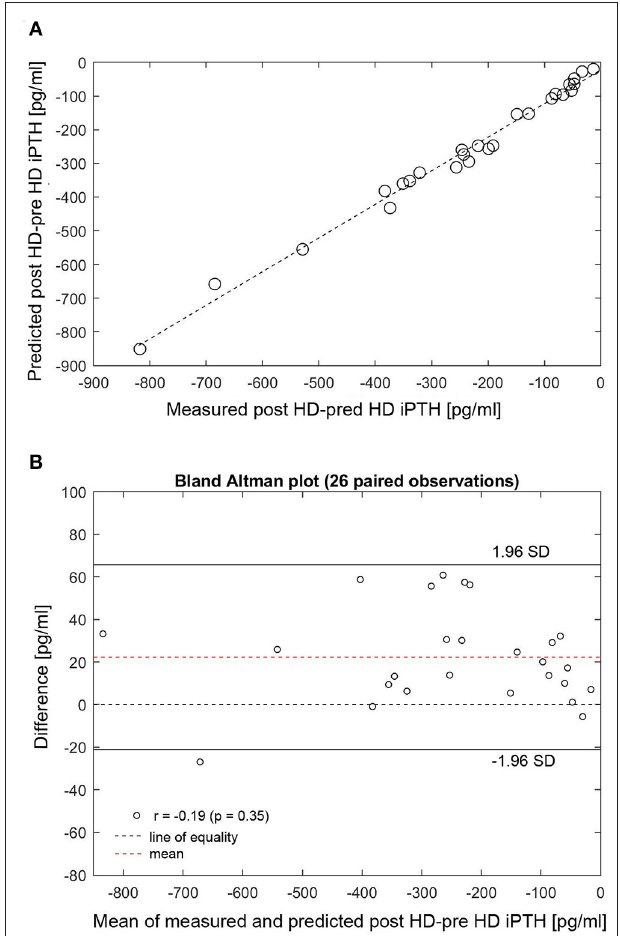
FIGURE 1 | Intradialytic iCa and iPTH kinetics in two patients. (A,B) Left: Interpolated iCa (black line) is based on measured iCa concentrations (red circles). Right: iPTH dynamics (black line) as predicted by the patient specific PTG model. The red circles indicate measured iPTH levels pre- and post-dialysis, respectively. The black circles indicate simulated iPTH levels pre- and post-dialysis, respectively. HD, hemodialysis; iCa, ionized calcium; iPTH, intact parathyroid hormone.